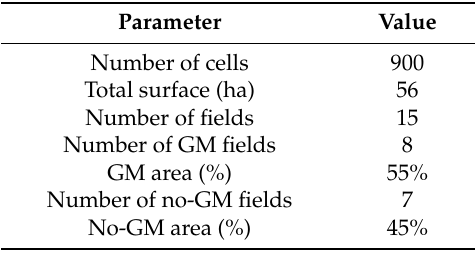
Table 3. Parameters defining the heterogeneous landscape.